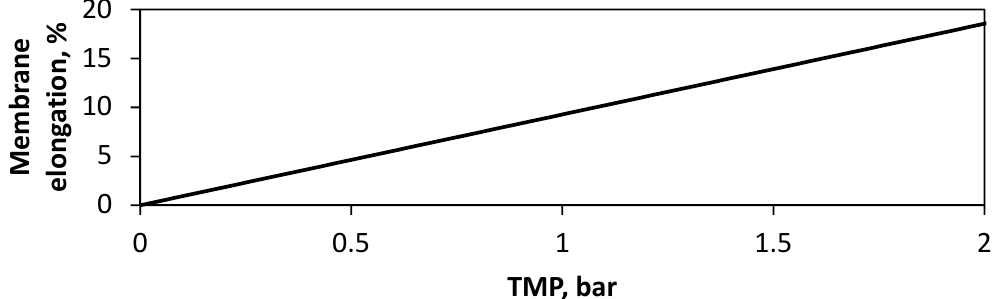
Figure 2. Relationship between the transmembrane pressure (TMP) applied in the Forward osmosis (FO) system and expected elongation of the membrane.